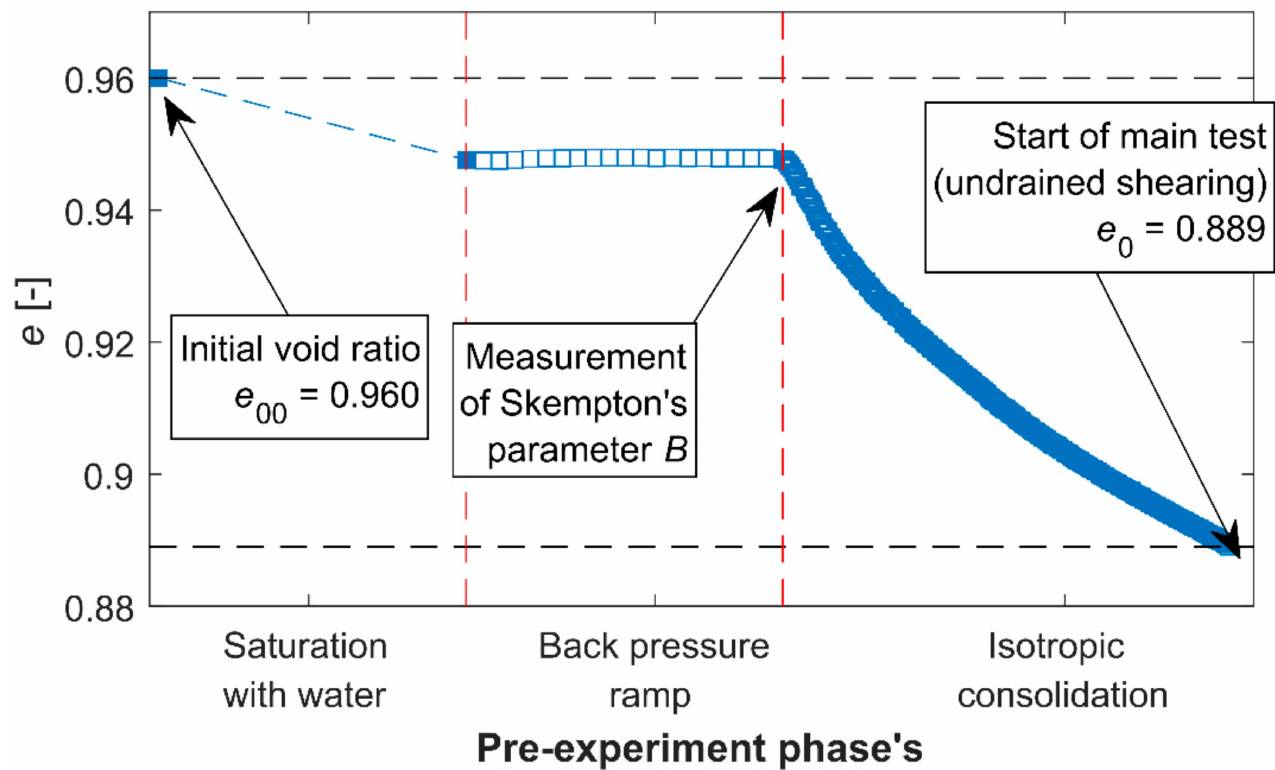
Figure 7. Tracking changes in void ratio in the b1